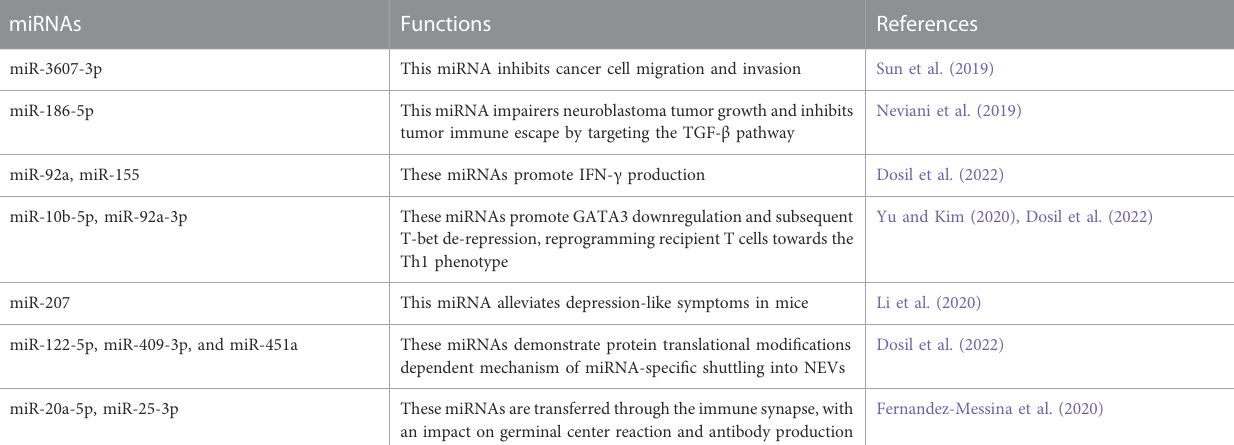
TABLE 4 The functions of miRNAs contained in NEVs.